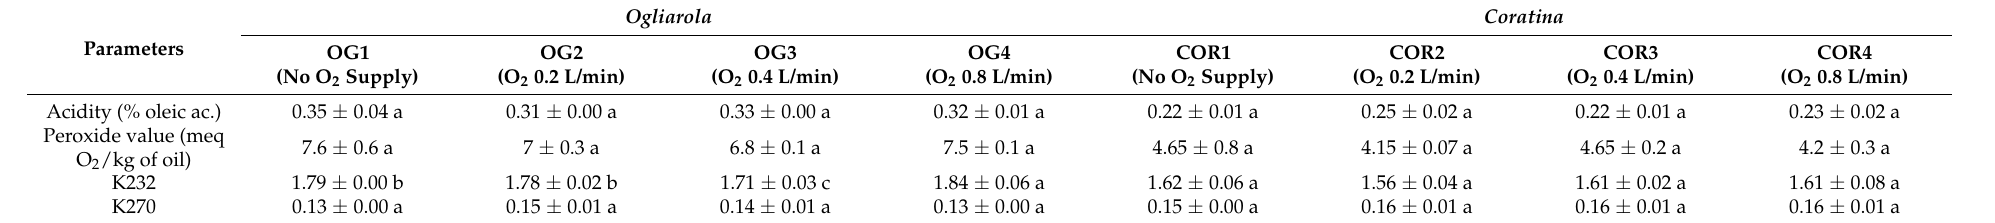
Table 1. Legal quality parameter of VOOs extracted with different values of oxygen flow during the crushing